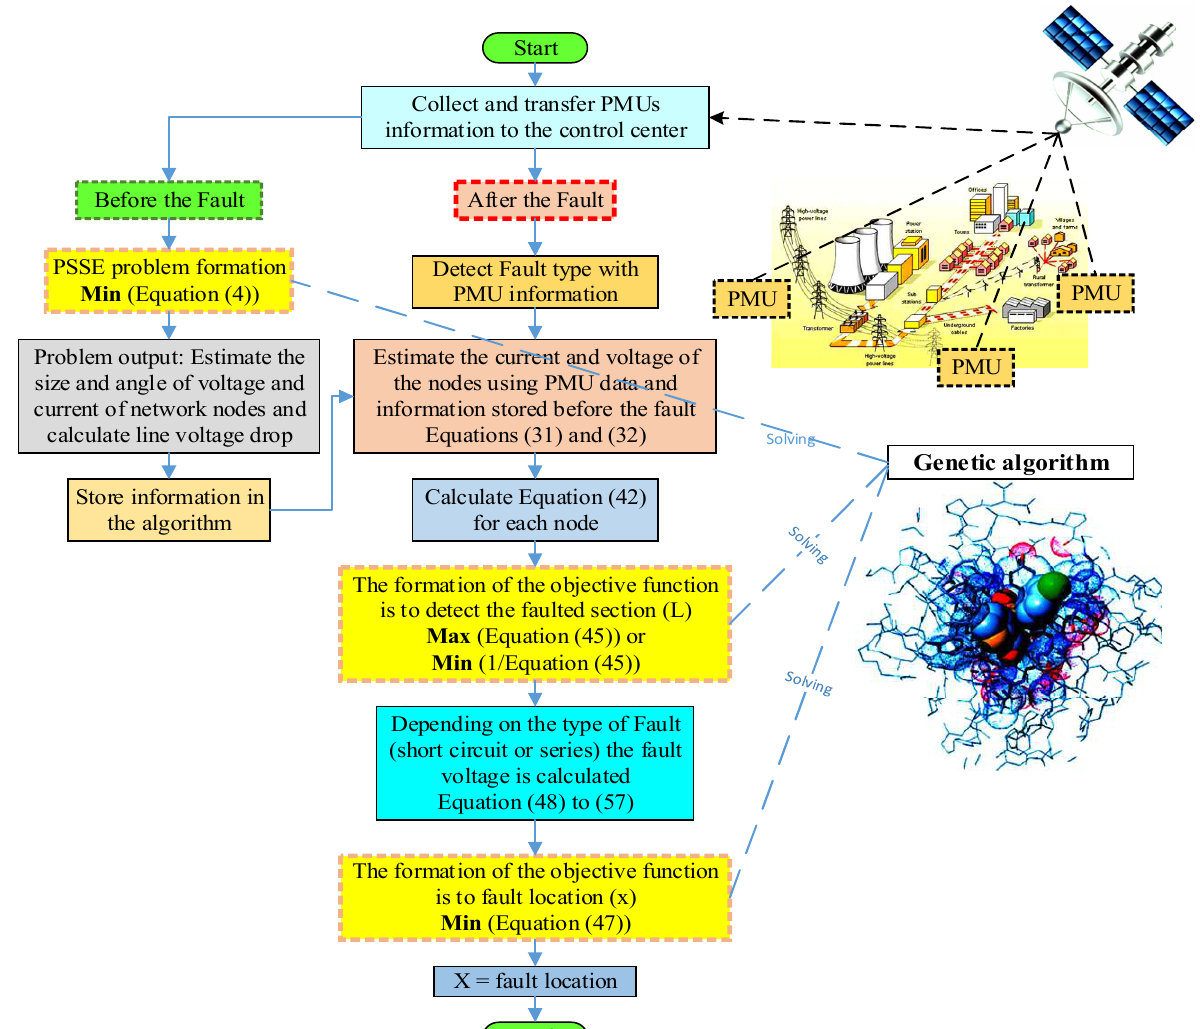
Figure 14. Flowchart of the steps of the proposed